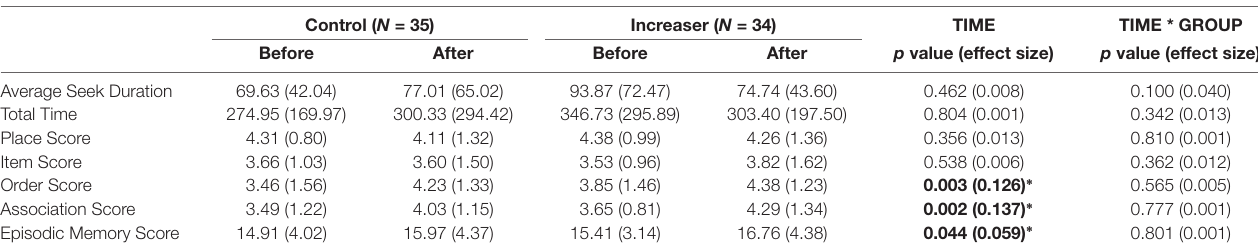
TABLE 5 | Spatial navigation test. Control ( N = 35) Increaser ( N = 34) TIME TIME * GROUP Before After Before After p value (effect size) p value (effect size)